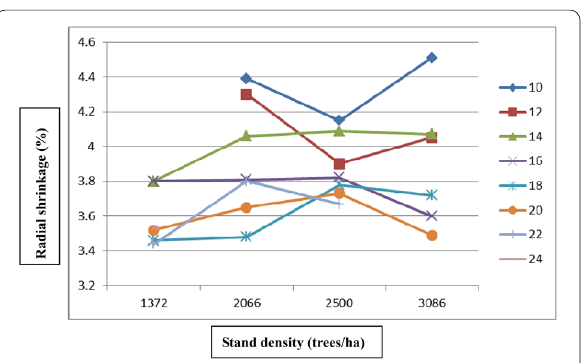
Fig. 3 Radial shrinkage in relation to stand density and DBH class